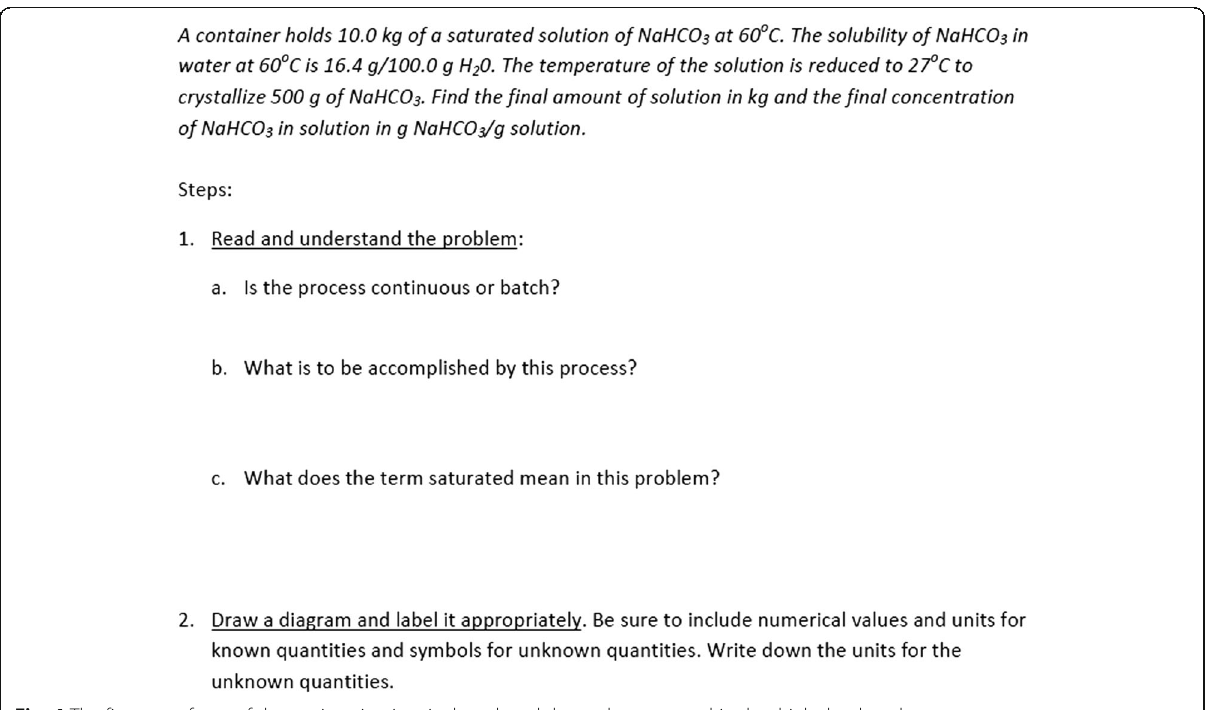
Fig. 4 The first part of one of the engineering inquiry-based worksheets that was used in the think-aloud